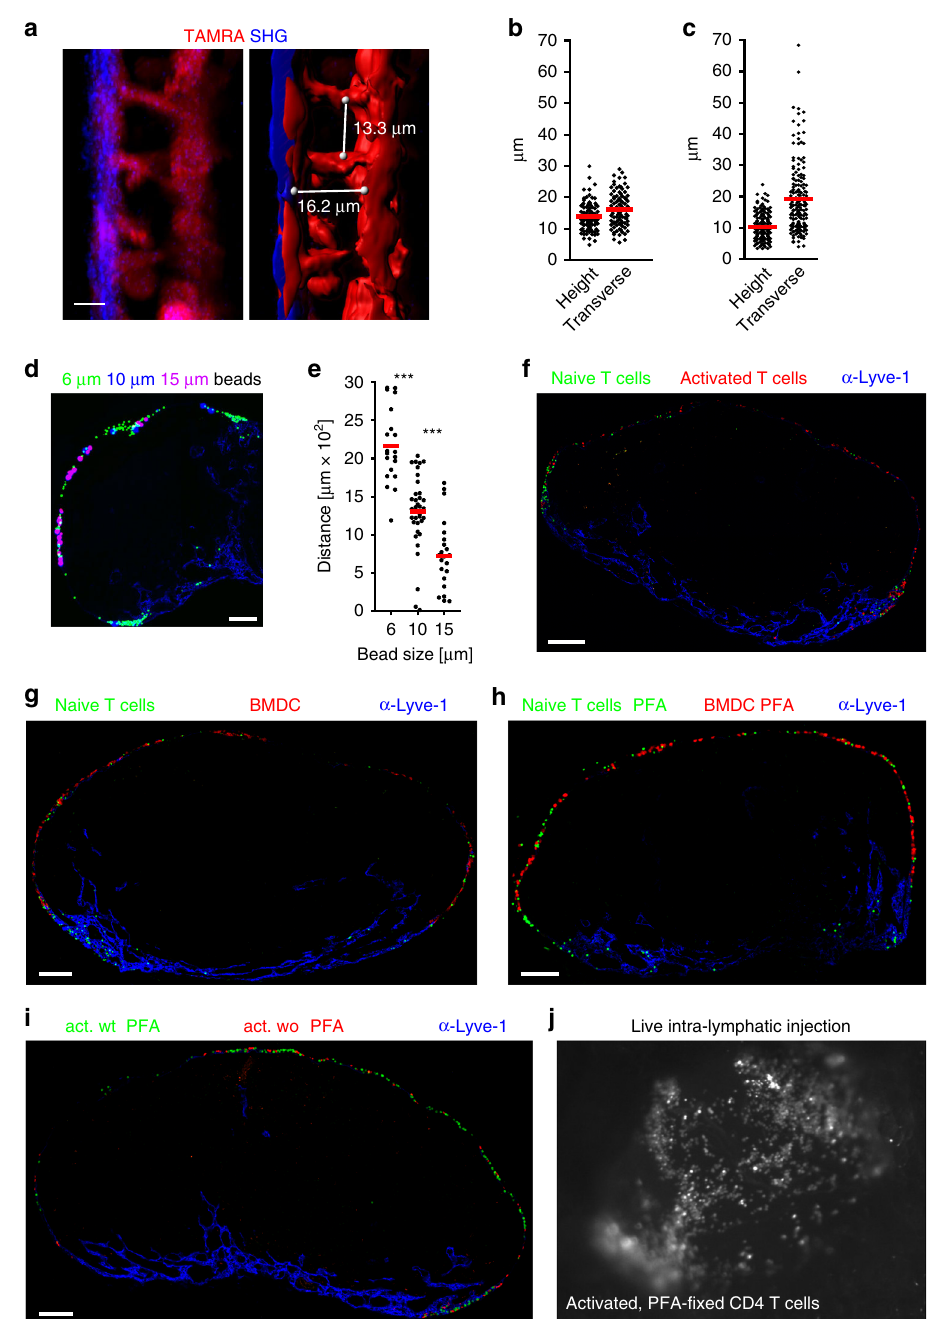
Fig. 3 The SCS represents a 3D sieve that acts as a mechanical barrier to arrest lymph-derived activated CD4 T cells. a In vivo imaging and three- dimensional reconstruction of an in fl amed pop LN SCS after subcutaneous injection of TAMRA. White lines indicate measure points for SCS height and transverse distance between cells/ fi bers. b , c Quantitative analysis of SCS heights and transverse distances in resting ( b ) and in in fl amed ( c ) pop LNs. d , e Immuno- fl uorescence microscopy ( d ) and quantitative analysis ( e ) of latex bead positioning in popliteal LN SCS after intra-lymphatic injection of fl uorescent latex particles (6 µ m, green; 10 µ m, blue; 15 µ m, pink) showing the farthest distance along the SCS between beads of the same size; blue, counterstaining with anti-Lyve-1. f – i Immunohistology of popliteal LNs directly after i.l. injection of cells as indicated; j snapshot of i.l. live injection of activated PFA-treated CD4 T cells. a – c Representative images and analysis of 5 – 6 LNs analyzed per group in fi ve independent experiments